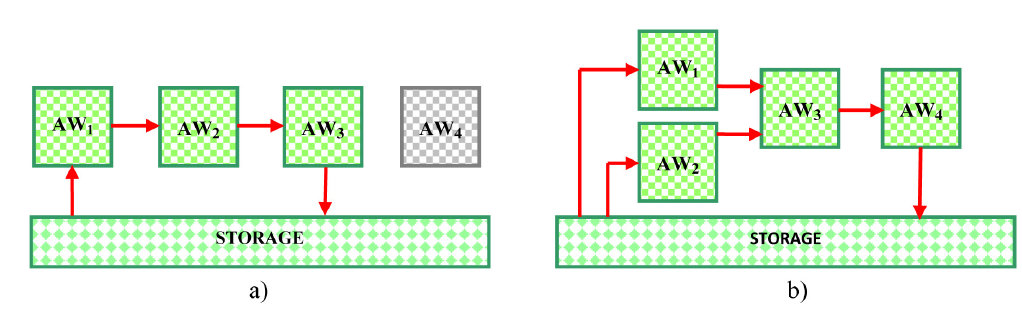
Figure 2: Examples of possible workstation links in the on-line analysis model a) three active assembly workstations (AW); b) four linked assembly workstations, of which two are parallel in terms of material flow.